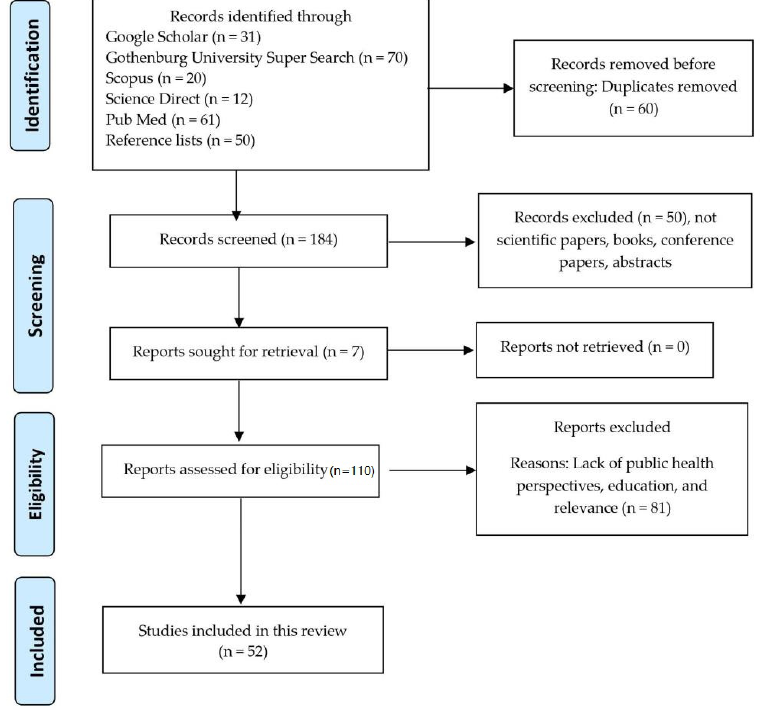
Figure 1. PRISMA 2020 flow diagram for new systematic reviews [44].